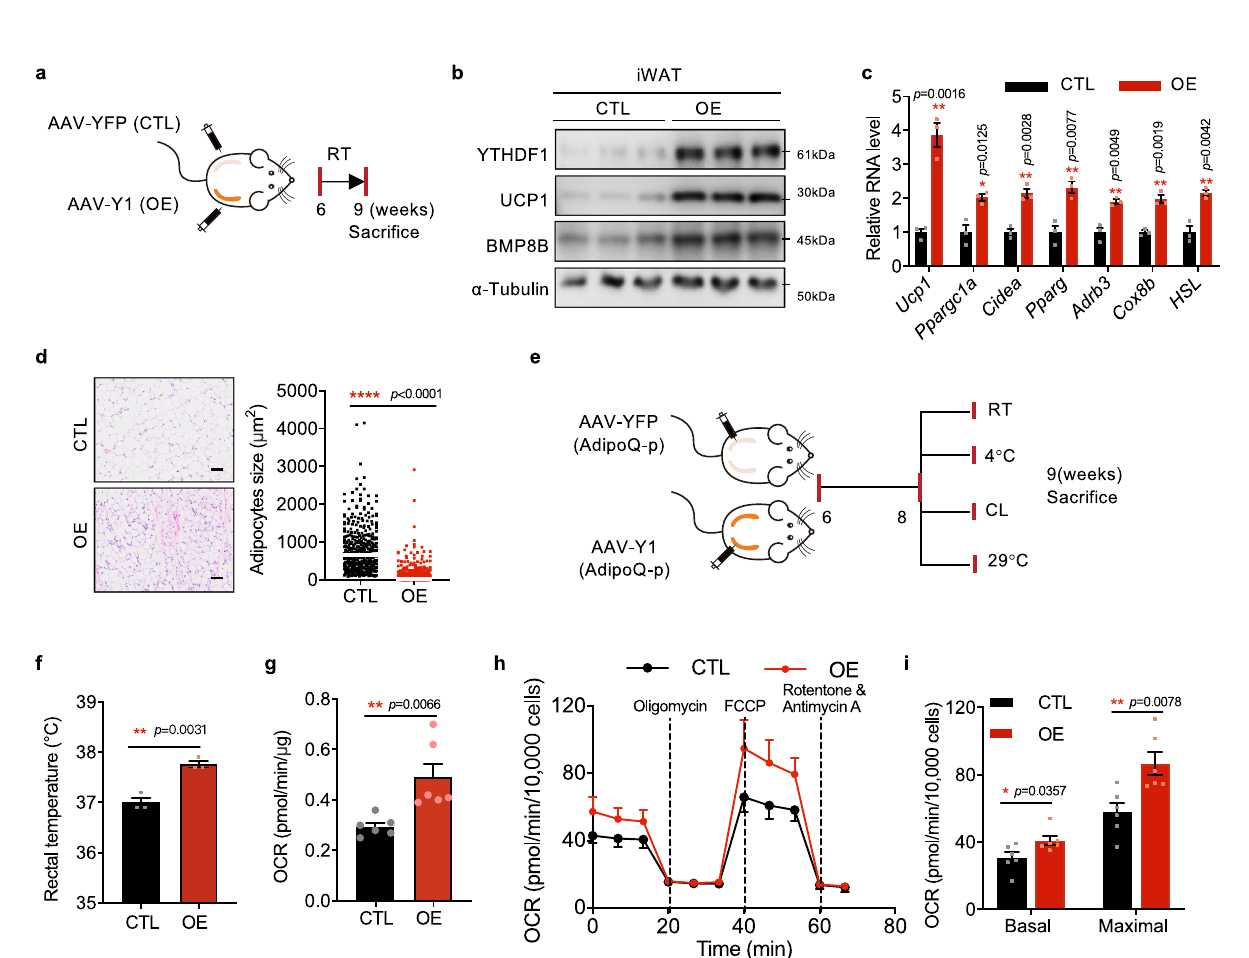
Fig. 5 | YTHDF1 regulates BMP8B in an m 6 A-dependent manner. a The mRNA and protein levelsof BMP8BiniWAT from micetreated atRTor 4°C. b The mRNA andproteinlevelsofBMP8BiniWATfrom Y1 CTL and Y1 cKO micetreatedat4°C. c The mRNA level of Ythdf1 and Bmp8b in 3T3-L1 cells with or without YTHDF1 knock- down. d The protein levels of BMP8B expression in 3T3-L1 cells with or without Ythdf1 knockdown. e Polysome pro fi les of 3T3-L1 cells with or without YTHDF1 knockdown. f Thedistributions of Gapdh and Bmp8b in polysome fractions. g m 6 A peak distribution within Bmp8b transcripts. * indicates the predicted m 6 A peak. h Schematicof luciferaseconstructs withthepredictedm 6 Asites inthe CDSand3 ′ UTRof Bmp8b mRNA. i Luciferaseactivityofthe Bmp8b reporterin3T3-L1cellswith